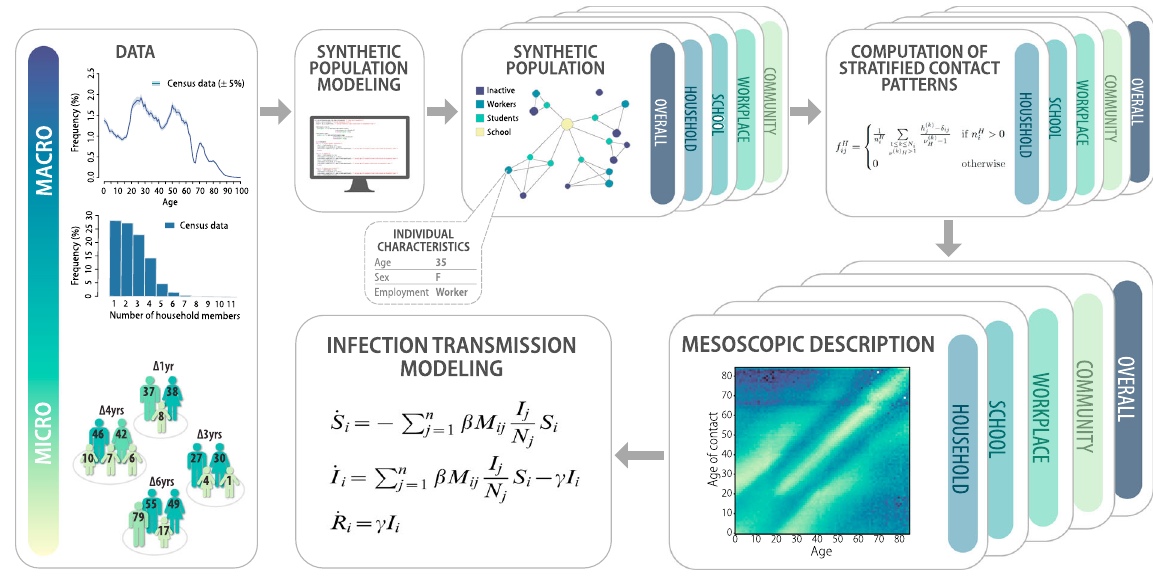
Fig. 1 Modeling framework. Schematic representation of the work fl ow for modeling human-mixing patterns and infection transmission